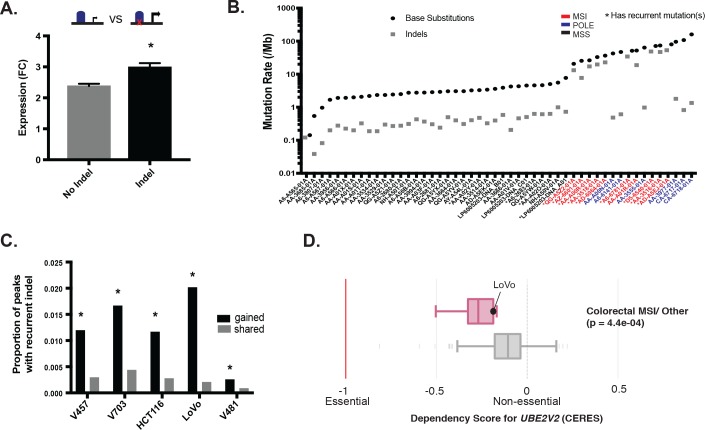
Recurrent MSI enhancer indels are enriched in gained enhancers.(A) Mean fold-change of expression (CRC/crypts) of genes corresponding to all gained enhancers containing indels (n = 10,971 gene-sample pairs; grey), versus the same genes in cell lines with gained enhancers but lacking indels (n = 58,412 gene-sample pairs; black). *p<0.05, 2-sample t-test. (B) Rate of substitutions and indels detected in cohort of 50 primary CRC samples, ordered by total mutation rate. (C) Proportion of gained enhancers (black) and enhancers shared with normal crypt (grey) with at least one indel recurrent in primary CRC tumors. *p<0.05, Z-test of proportions. (D) Distribution of dependency scores for UBE2V2 in MSI lines (red) compared to all other lines (grey), from the DepMap CRISPR-knockout screen. Black dot indicates score for LoVo cell line. P value is from 2-sample t-test.